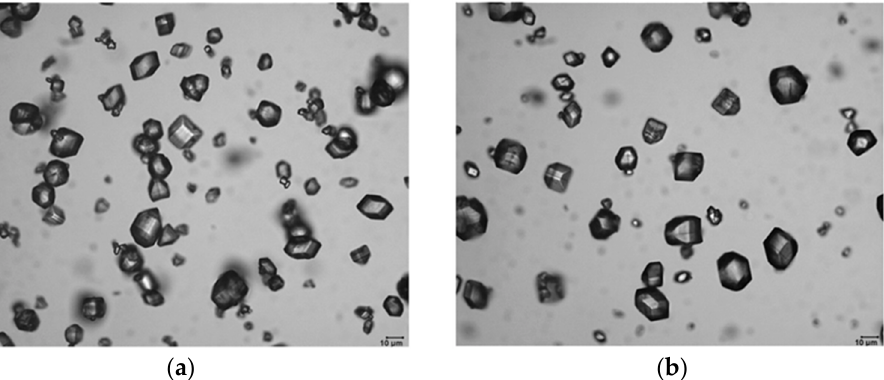
Figure 2. Optical microscopy pictures of α − AlH 3 . ( a , b ) are optical microscope pictures of α − AlH 3 at different magnification. Reprinted with permission from Ref. [28]. Copyright 2009 WILEY-VCH Verlag GmbH & Co. KGaA, Weinheim.